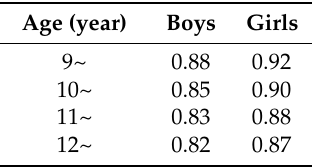
Table 2. Waist–hip ratio reference norm for screening obesity in Chinese children and adolescents